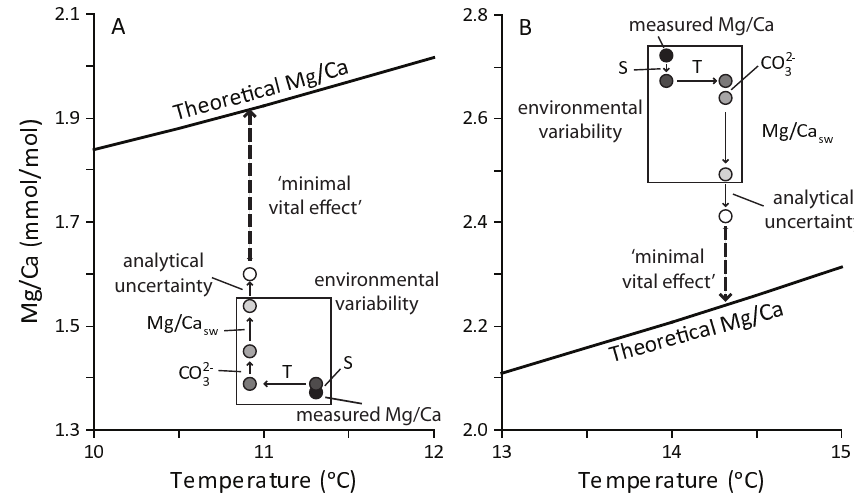
Fig. 5. Maximum correction for variability in culture parameters for measured Mg/Ca values of B. marginata no. 52 (A) and no. 67 (B) (num- bers corresponding to Table 2). Corrections are based on the maximum variability of each experiment (Table 3). Variability was expressed as a correction in foraminiferal Mg/Ca using the same relations as for Fig. 4.